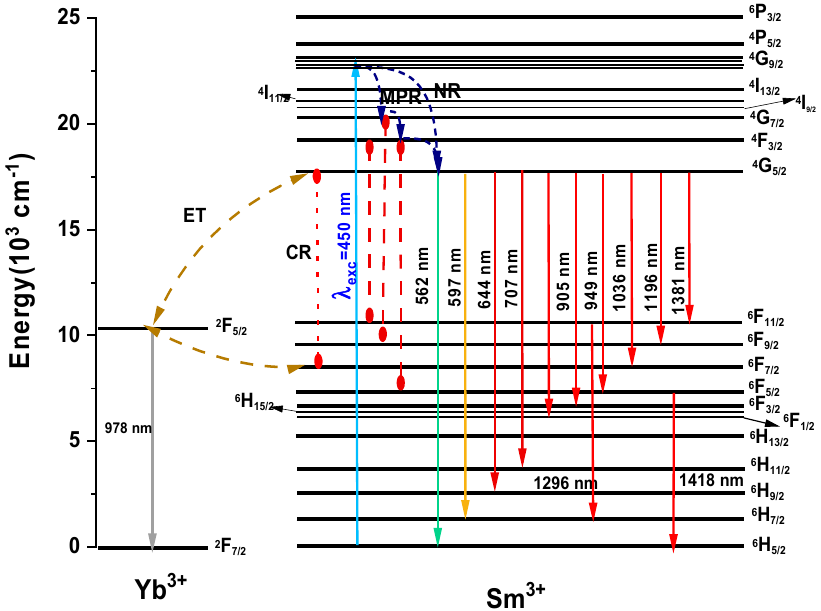
under a 450 nm wavelength excitation. An average diode laser power of 60 mW was employed to excite the glass samples.